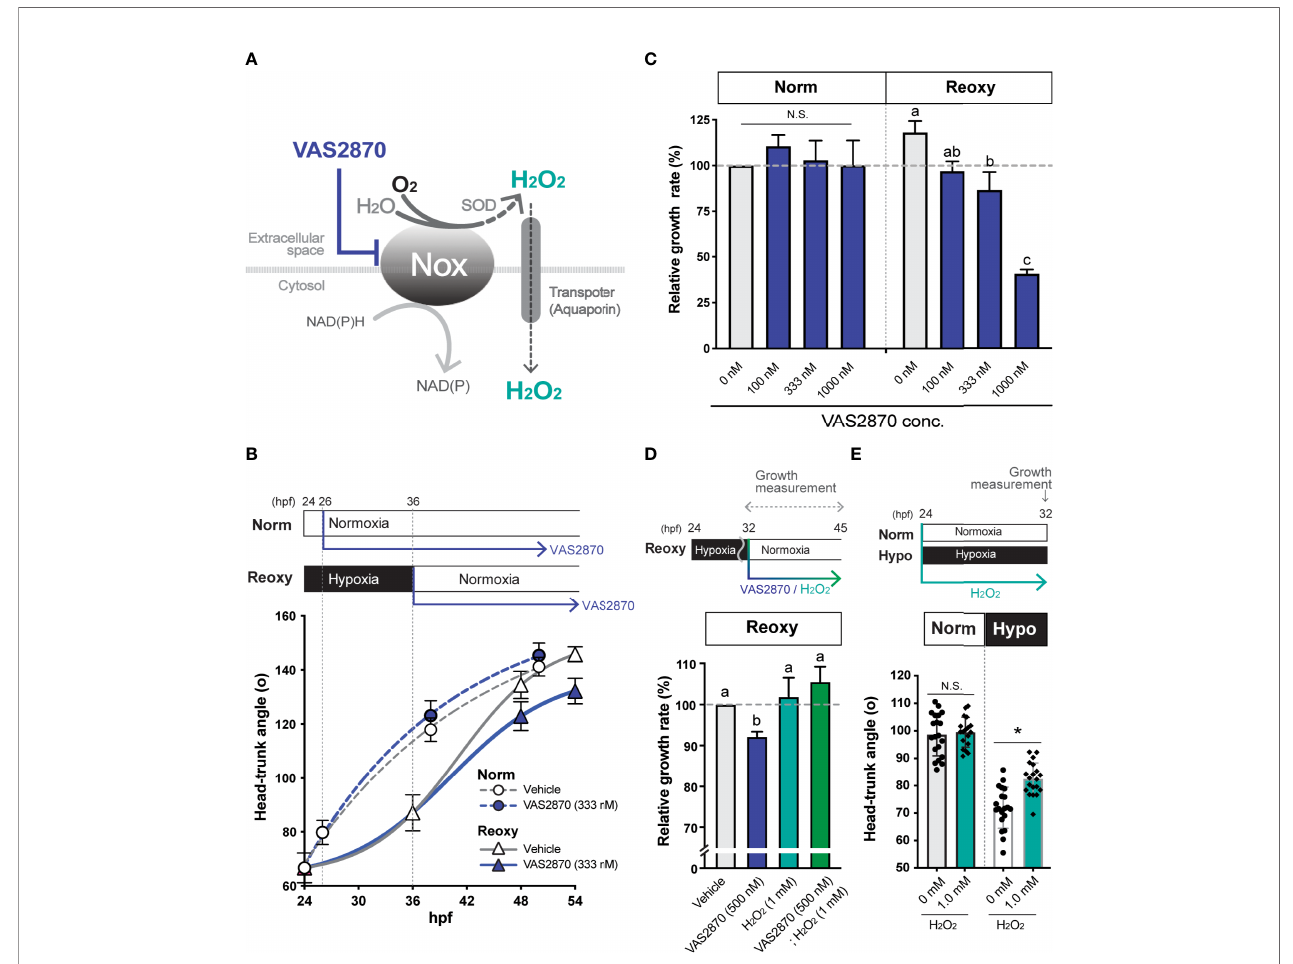
FIGURE 3 | NADPH-oxidase (Nox)-generated H 2 O 2 is crucial for the hypoxia/re-oxygenation-induced embryonic catch-up growth. (A) Schematic diagram of NADPH oxidase (Nox) function, which produces H 2 O 2 , a redox signaling molecule, near the plasma membrane. The Nox inhibitor, VAS2870, reduces the Nox-dependent production of H 2 O 2 in the vicinity of the plasma membrane. Most Nox generate superoxide which is converted to the H 2 O 2 by superoxide dismutase (SOD). (B, C) Effects of the Nox-inhibitor VAS2870. Wild-type zebra fi sh embryos were raised following the experimental regime depicted in the panel (B) diagram. Head-Trunk Angle (HTA) was determined at the indicated time points (B) . Data are average ± SD, n=9-20. (C) Changes in the relative growth rate of embryos in the Norm (26-38 hpf) and Reoxy (36-48 hpf) groups. The control (vehicle=0.1% DMSO) group was set as 100%. Data are mean ± SE of 3 independent experiments. Values marked with different letters (a, b, c) are signi fi cantly different from each other ( P<0.05 ), but values marked with common letters (a and ab; ab and b) are not signi fi cantly different from each other ( P>0.05 ). N.S. means not signi fi cantly different (P>0.05). (D) Changes in the relative growth rate of embryos in the Reoxy (36-48 hpf) embryos treated with or without VAS2870 and H 2 O 2 . The vehicle alone group was set as 100%. Data are mean ± SE of 3 independent experiments. Values marked with different letters (a, b) are signi fi cantly different from each other ( P<0.05 ). (E) Changes in HTA of the Norm and Hypo embryos at 32 hpf with or without 8 hr H 2 O 2 treatment. Data are average ± SD, n=18-20. The asterisk (*) denotes statistical difference at P<0.05 . N.S. means not signi fi cantly different